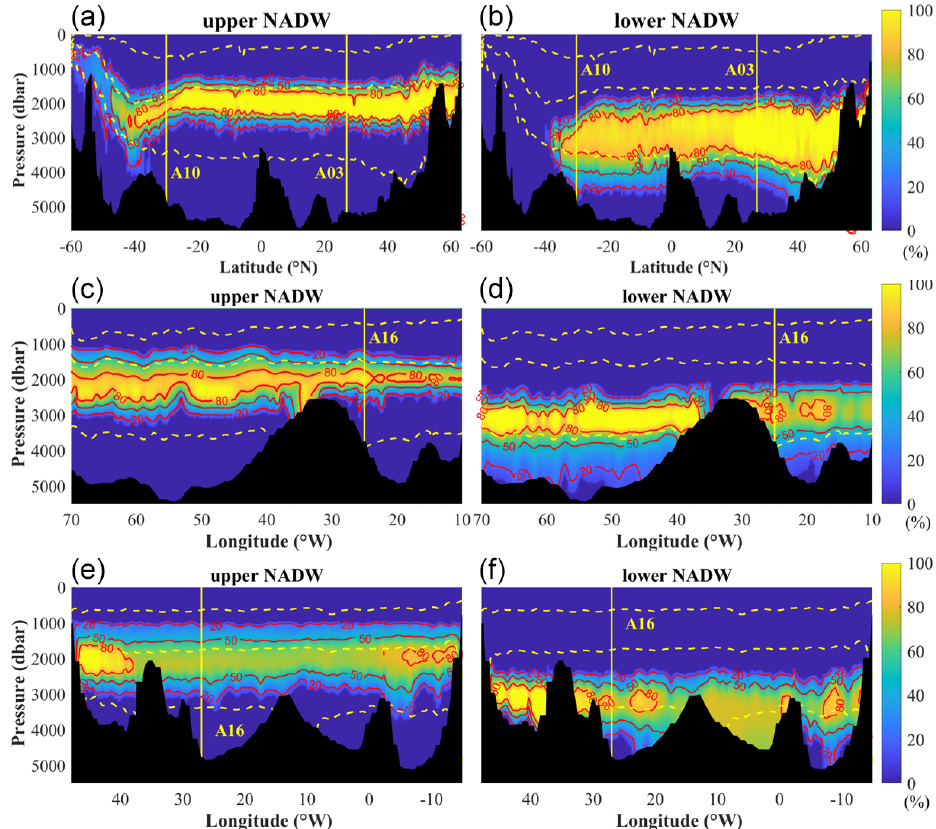
Figure 14. Distribution of upper and lower NADW based on the A16 (a, b) , A03 (c, d) and A10 (e, f) sections. Contour lines show fractions of 20%, 50% and 80%, yellow vertical lines show cross overs with other sections, and the dashed yellow lines show the vertical boundaries of layers (neutral density at 27.10, 27.90 and 28.10kgm − 3 ).